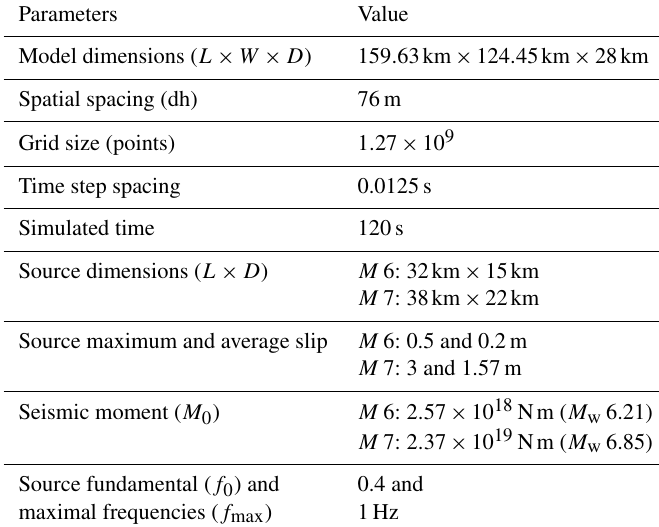
Table 2. Main parameters of the numerical model.